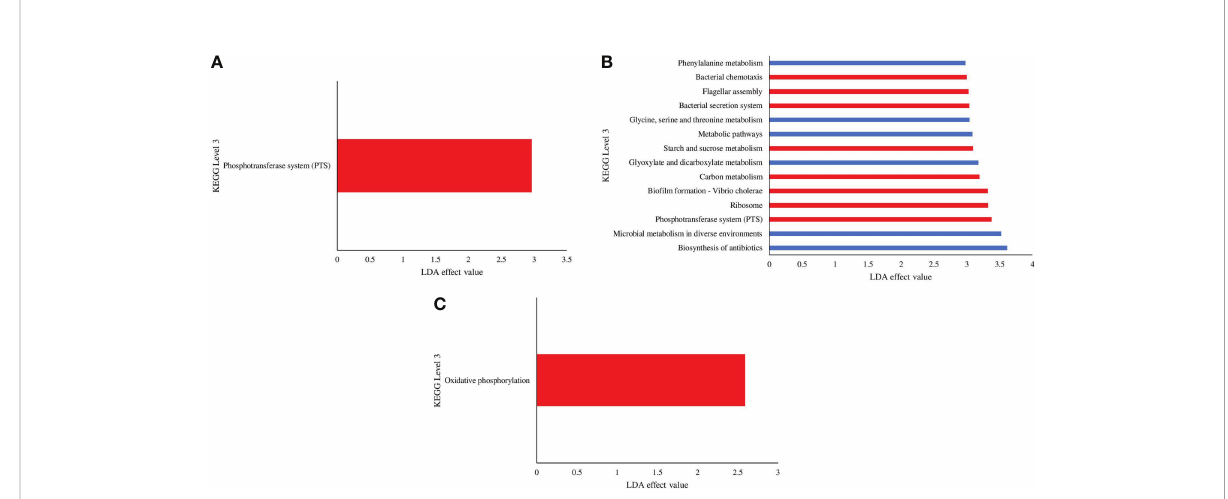
FIGURE 9 KEGG pathways found at signi fi cantly different abundances in the gut microbiota metagenomics pro fi les of Litopenaues vannamei cultured at (A) 5 ppt, (B) 20 ppt and (C) 30 ppt followed by exposure to Vibrio harveyi infection. The signi fi cant value is P < 0.05. All the P-value was less than 0.05. Red bars represent VH group, while blue bars represents C group (VH, Vibrio harveyi infected group and C, Control group; 5, 5 ppt, 20, 20 ppt and 30, 30